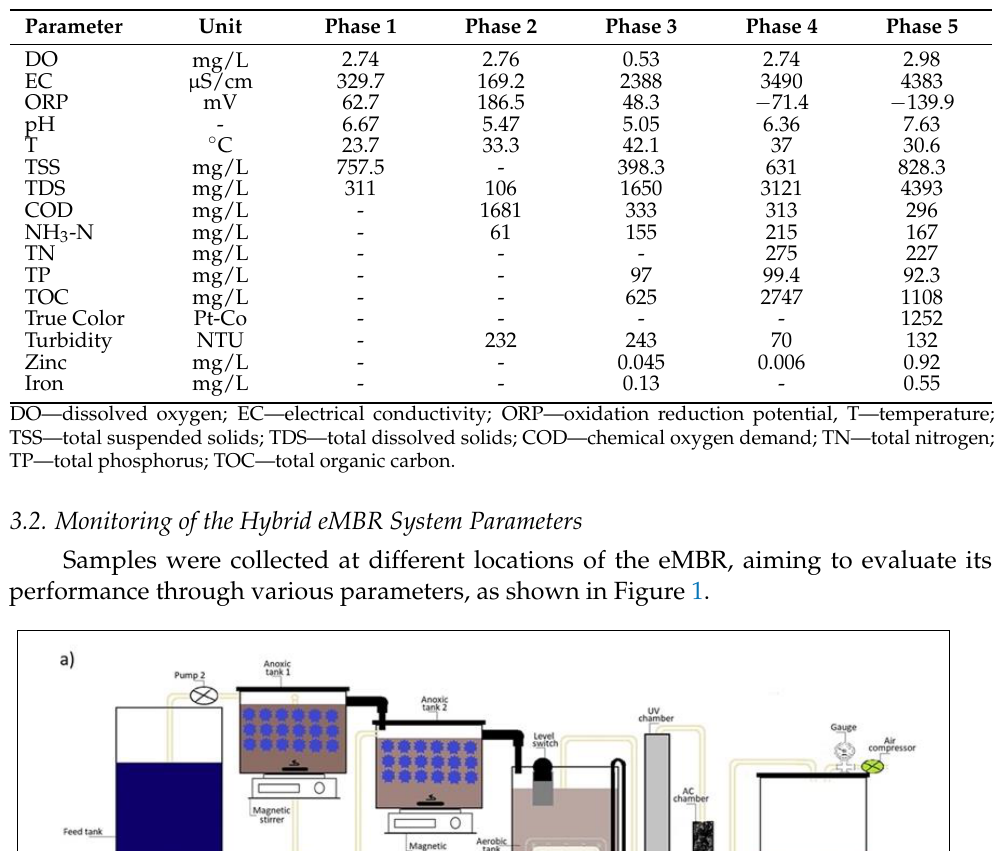
Table 4. Average feed characteristics during each process phase.